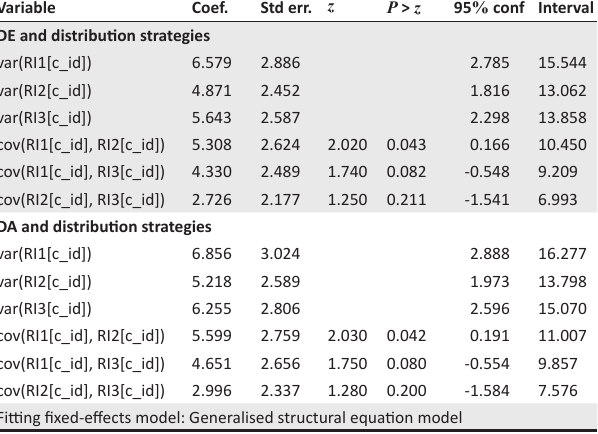
TABLE 1-A1: Summary statistics for the multinomial logistic regression fixed effects.